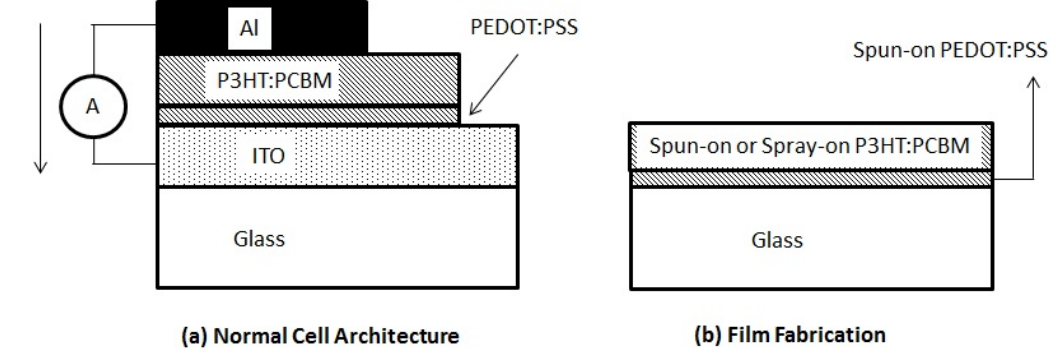
Figure 1. ( a ) Conventional PSC architecture, and ( b ) film fabrication sequence followed